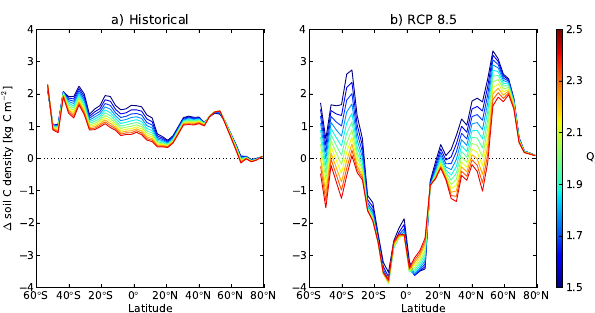
Figure 7. Zonal change in soil C density during historical simula- tions (a) and RCP 8.5 (b)